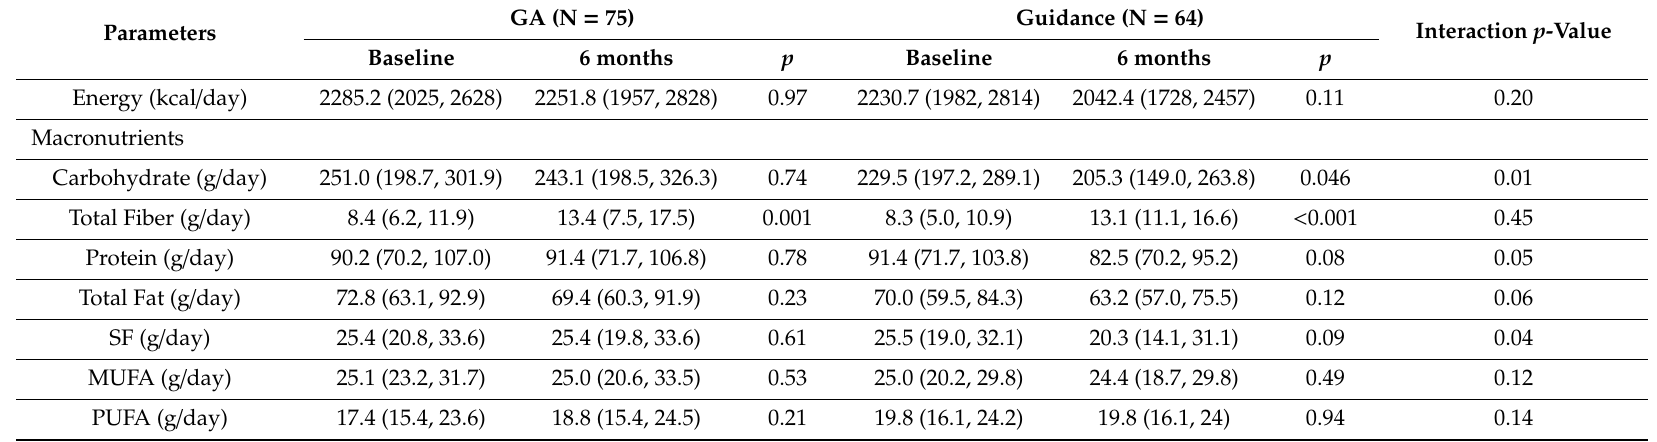
Table 3. Changes over time in nutrient